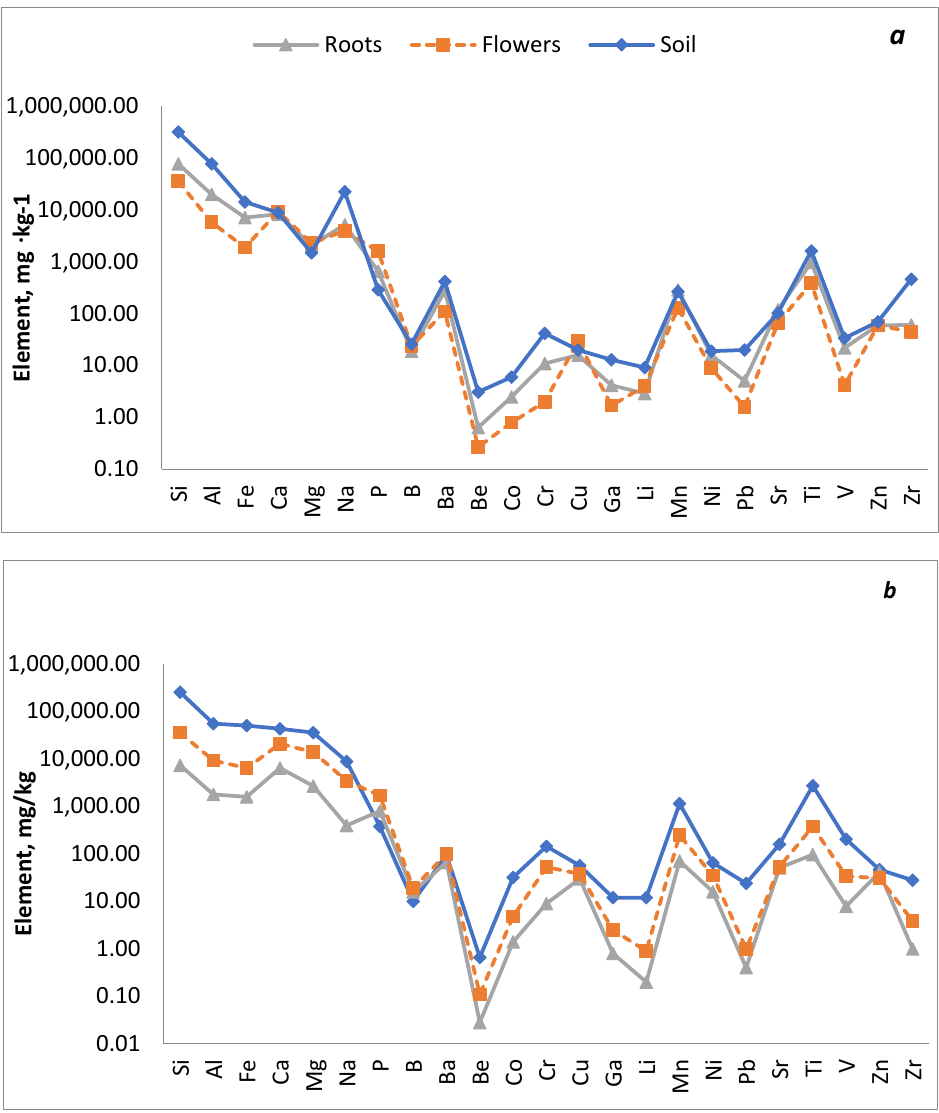
Figure 3. Element contents in the soils, roots and flowers of plants: ( a ) Thymus serpyllum L. (Mongolia, Ulaanbaatar); ( b ) Thymus baikalensis Serg. L. (Russia, Irkutsk). Silicon is probably a necessary element of Thymus species due to the fact that its content is the largest in flowers and comparable to the essential elements (i.e., potassium and calcium). The mineral contents of plants are quite variable, but their composition is strongly controlled through genetic means. This is evidenced by the near-identical contents in the flowers of the biophilic K, Na, P, B, Cu and Zn but also Si and Ti as conditionally biophilic elements, which are rarely determined in plants (Table 1, Figure 2). The V, Mn, Ba, Sr and Al contents in the flowers of the two species, growing in different natural and climatic conditions, varied no more than twice. Some of the elements found were redox- active, which makes them indispensable as catalytically active cofactors in enzymes; the others demonstrate enzyme-activating functions, while the third group of elements play a structural role in protein stabilisation. The role of each element in the biosynthesis of numerous volatile organic compounds in plants of this species is yet to be fully